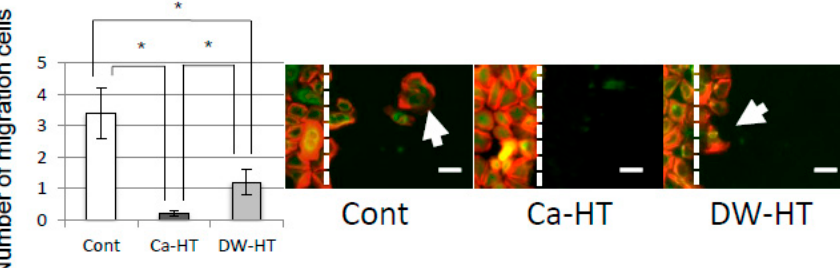
Figure 9. Scratch assay. (Left) The number of migrating cells on each substratum. Bars represent the mean ± SD. * P < 0.05. (Right) More cells (arrows) in both control and DW-HT groups were migrated into the scratched area (right side of the dotted line) than those in Ca-HT group. Bar = 20 μ m.